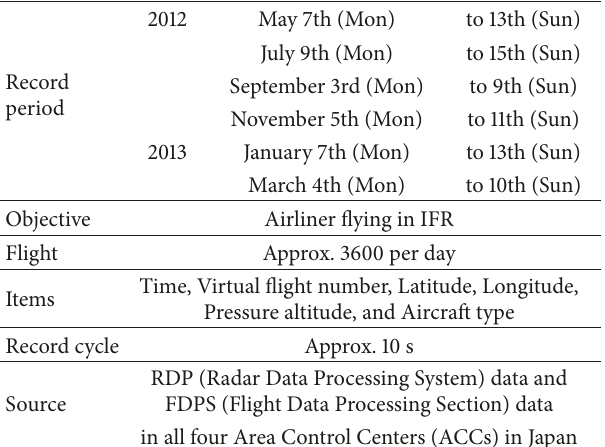
Table 1: Overview of CARATS Open Data [18, 20].